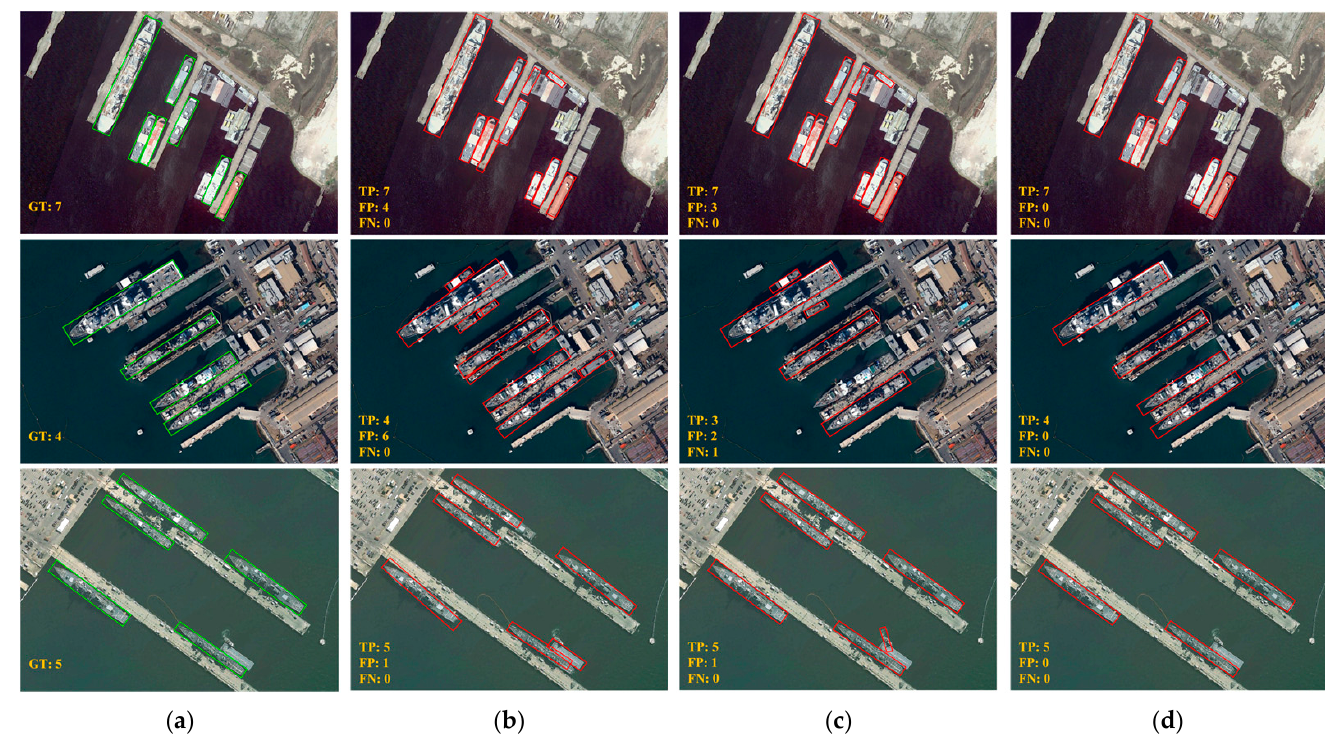
Figure 26. Detection results of different methods on HRSC2016. ( a ) GT; ( b ) CS 2 A-Net; ( c ) GWD; ( d ) TDIoU + AW-FPN (ours).